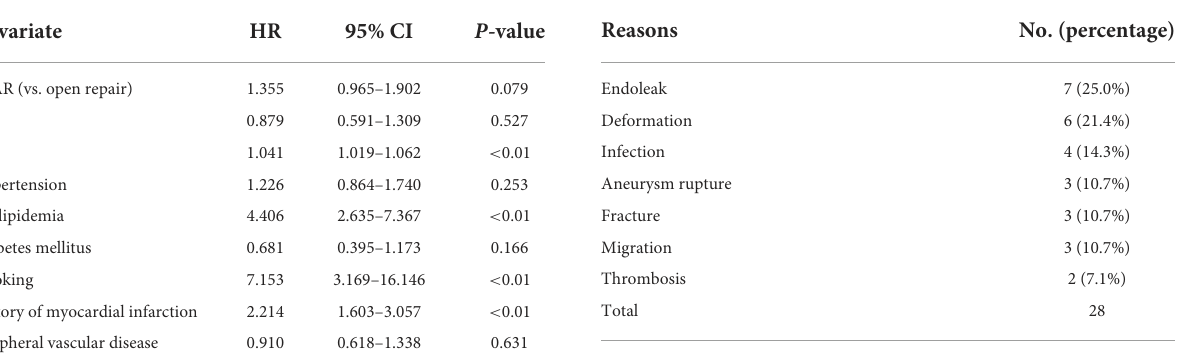
TABLE 8 Reintervention rate in the EVAR group after discharge due to graft-related